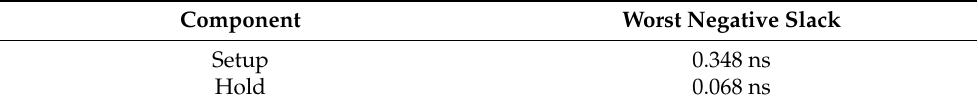
Table 3. The timing of the TDC system.